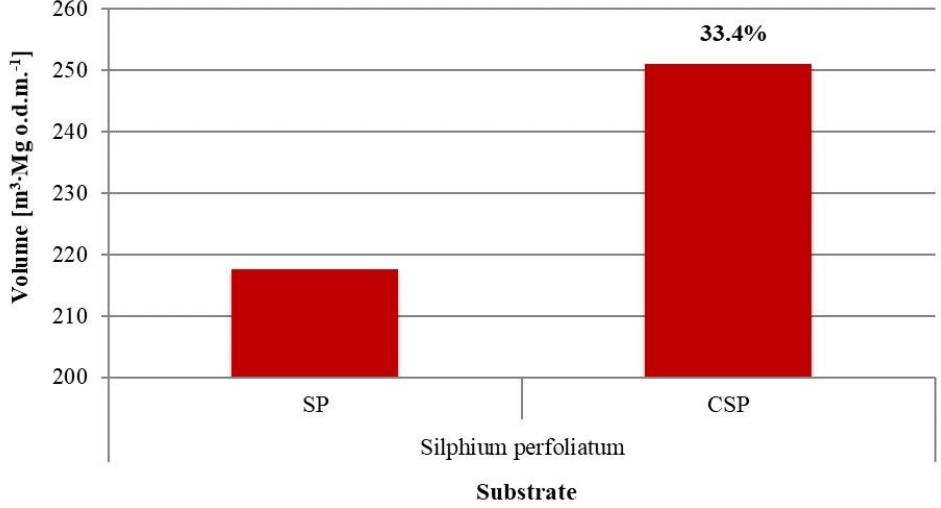
Figure 5. The cumulative methane production output from the non-comminuted and comminuted substrates per organic dry matter content.